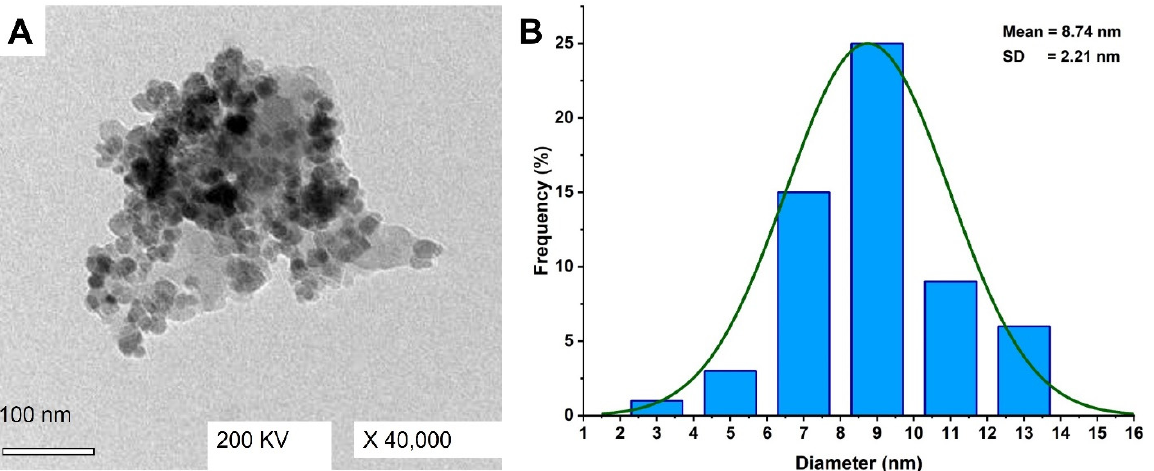
Figure 3. Characterization of Ag-NPs formed by biomass filtrate of A. niger strain F2. ( A ) is the TEM image, and ( B ) is the size distributions based on the TEM image.